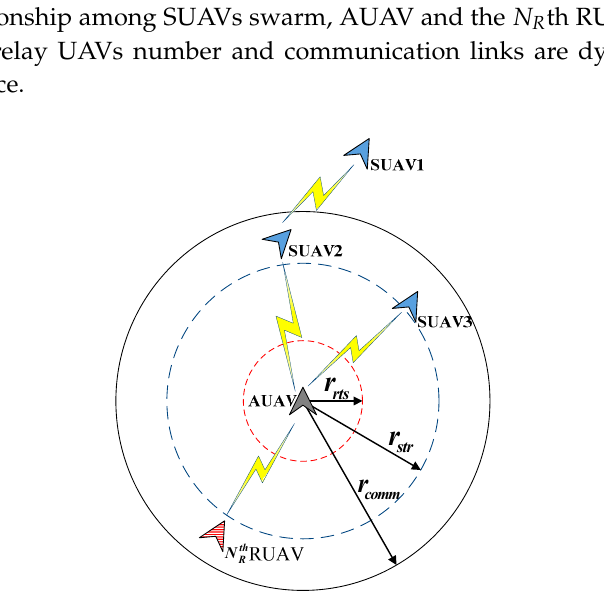
Figure 4. Geometry relationship among RUAV, AUAV and SUAVs in role conversion stage.